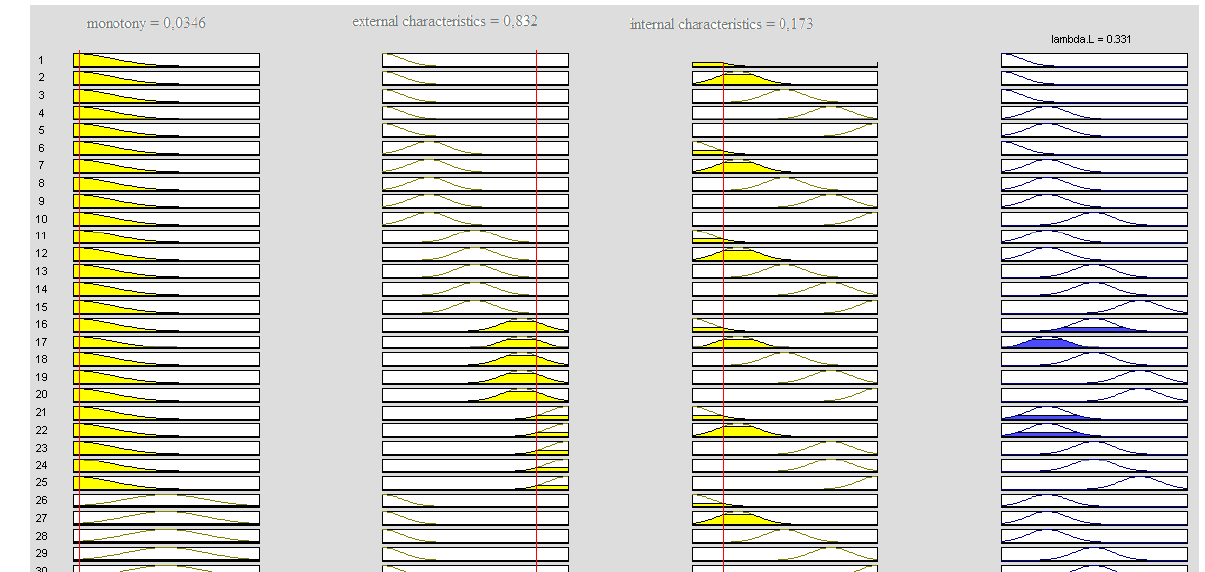
Figure 6. Visualization of implication rules for simulation λ L .